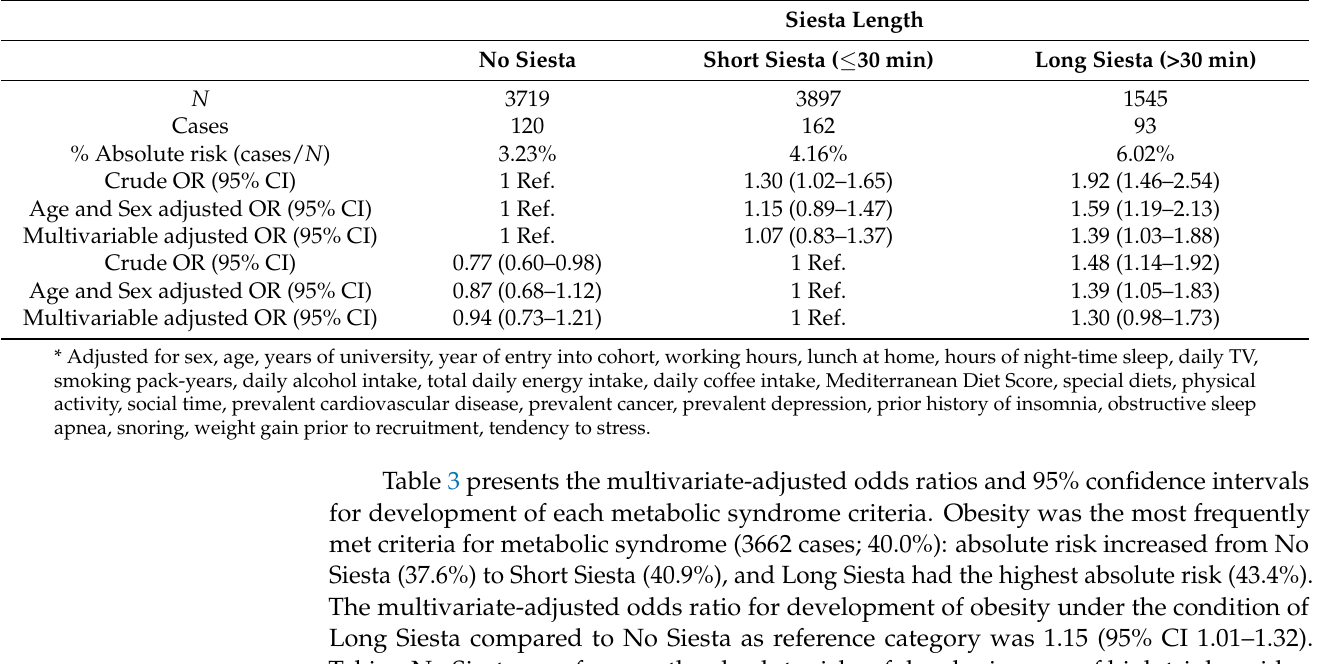
Table 2. Adjusted odds ratios (aOR) * and 95% confidence intervals (CI) for the development of metabolic syndrome according to siesta length in the SUN